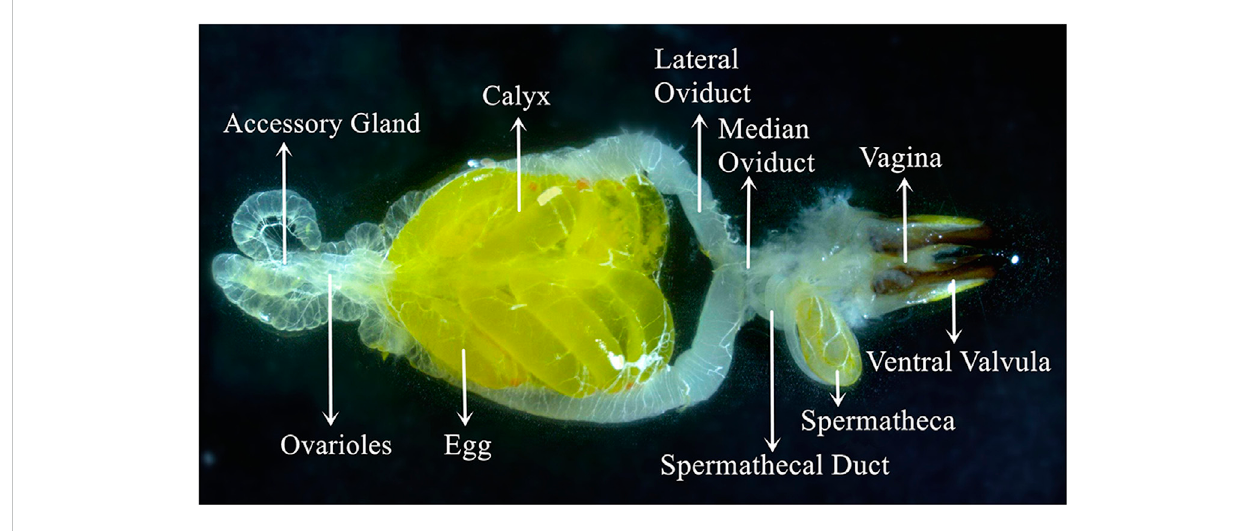
FIGURE 3 Visual view of the C. kiangsu ovary at stage Ⅴ